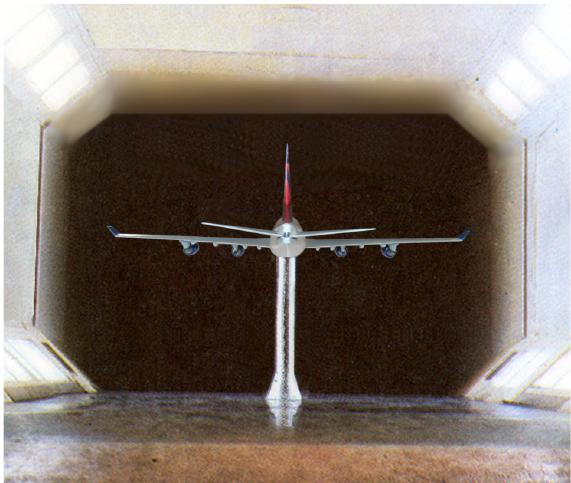
Figure 7. Photograph of the back of the airplane (airspeed =